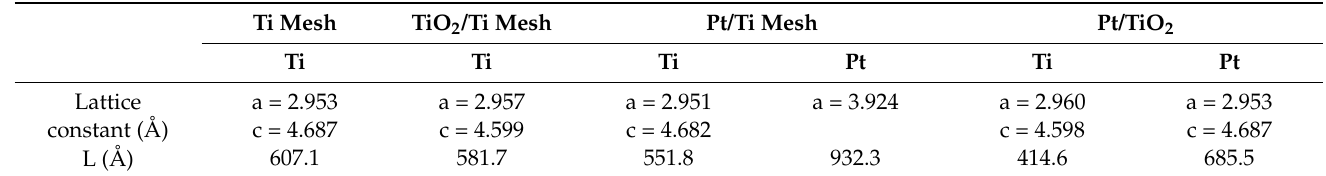
Table 1. XRD characteristics of the Ti mesh, TiO 2 /Ti mesh, Pt/Ti mesh and Pt/TiO 2 /Ti mesh.